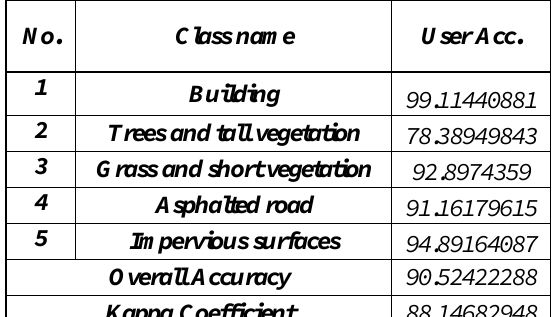
Table 2 - Results of the evaluation criteria for classification accuracy urban of the integration of the results of classification using multi-scale Orthophoto GASVM and fencing made from UAV images of the study